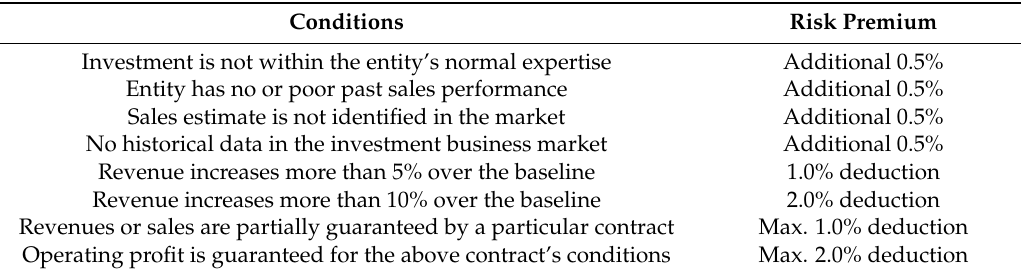
Table 8. Industry risk premiums (modified from [28]).